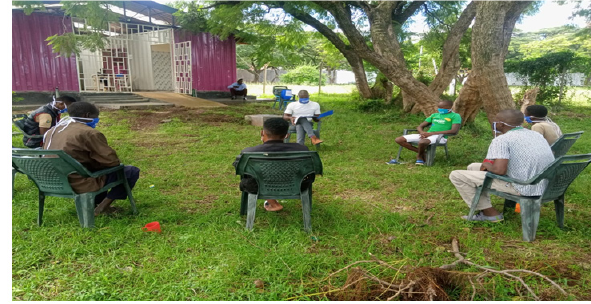
Figure 11. Meeting held between outreach workers and staff at Railways Health Centre,